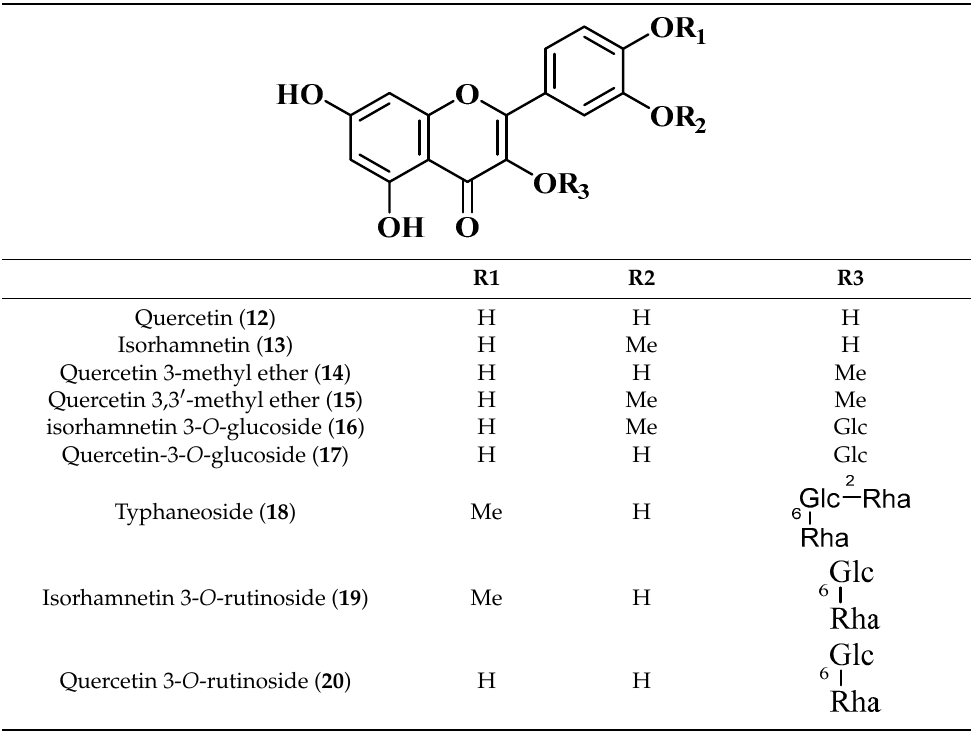
Table 4. Chemical structures for the most abundant flavonoids in jojoba.